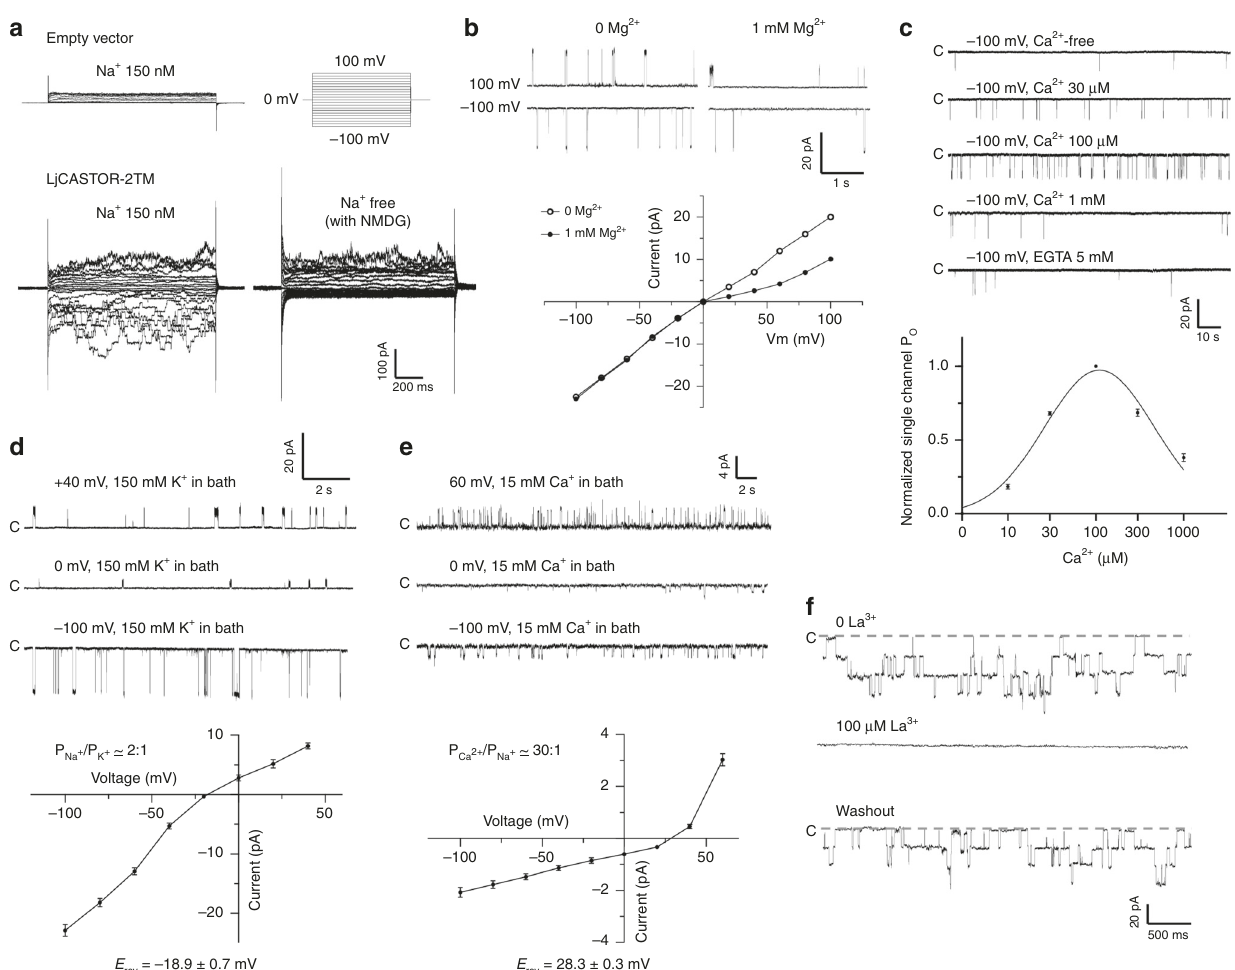
Fig. 1 Functional characterization of LjCASTOR-2TM reveals that LjCASTOR is a Ca 2 + -regulated Ca 2 + channel. a Whole-cell current recordings in the presence of 150 mM [Na + ] and 10 μ M [Ca 2 + ] in the pipette solution (intracellular) and 150 mM [Na + ] or NMDG in the bath solution. LjCASTOR-2TM is not permeable to NMDG. b Inward recti fi cation of the current caused by intracellular Mg 2 + ions. The recordings were obtained from the inside-out patches with the symmetrical 150 mM [Na + ] in the presence of 10 μ M [Ca 2 + ] and 0 or 1 mM [Mg 2 + ] in the bath solution (intracellular). c Cytosolic [Ca 2 + ]- dependent activation of LjCASTOR-2TM. The recordings were obtained from the inside-out patches with 150 mM [Na + ] in the pipette solution (extracellular). The bath solution (intracellular) contained 150 mM [K + ] with various [Ca 2 + ]. Data points are mean ± s.e.m. ( n = 5 independent experiments). d Selectivity of LjCASTOR-2TM between Na + and K + . Sample traces and I – V curve were obtained from the outside-out patches with 150 mM [Na + ] and 10 μ M [Ca 2 + ] in the pipette solution (intracellular) and 150 mM [K + ] in the bath solution (extracellular). P / P value was calculated Na þ K þ from the reversal potential ( E rev = mean ± s.d. of fi ve independent experiments). e Selectivity of LjCASTOR-2TM between Na + and Ca 2 + . Sample traces and I – V curve were obtained from the outside-out patches with 150 mM [Na + ] and 10 μ M [Ca 2 + ] in the pipette solution (intracellular) and 15 mM [Ca 2 + ] in the bath solution (extracellular). P / P value was calculated from the reversal potential ( E rev = mean ± s.d. of fi ve independent experiments). Na þ Ca 2 þ f Inhibition of LjCASTOR-2TM by La 3 + . The recordings were obtained from the outside-out patches with 150 mM [Na + ] and 10 μ M [Ca 2 + ] in the pipette solution (intracellular) and 150 mM [Na + ] and 0 or 100 μ M [La 3 + ] in the bath solution